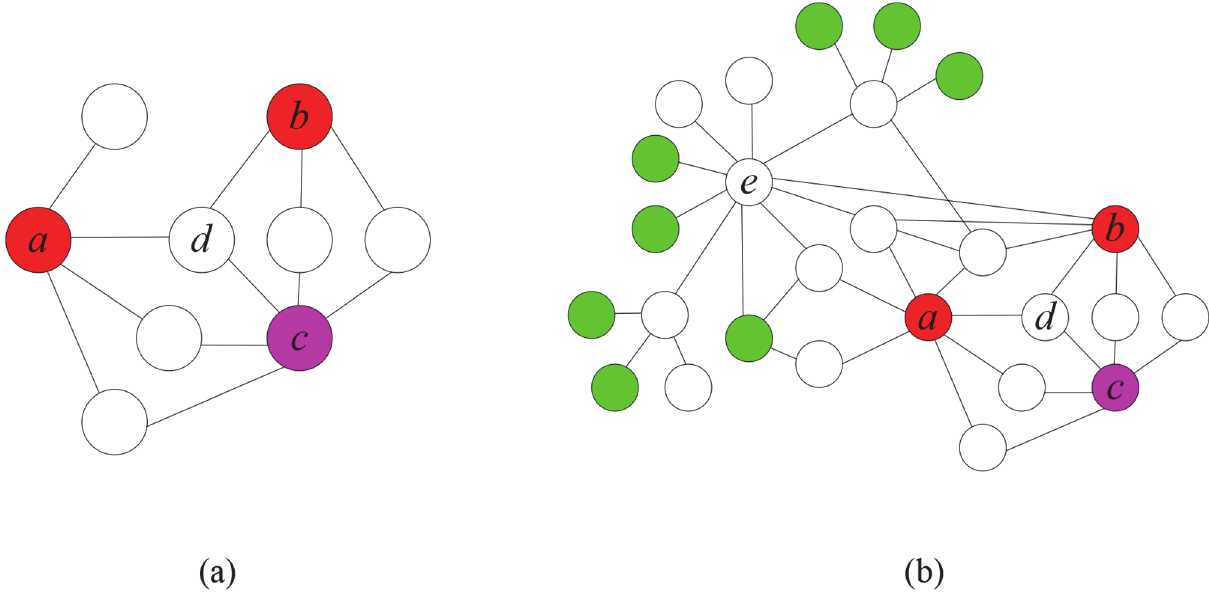
Fig 3. An example of gene prioritization based on network. (a) The disease proteins a and b are selected as the training set, while c as the test disease protein. (b) Global distance measurements may mistake the non-disease hub protein e for a disease protein.